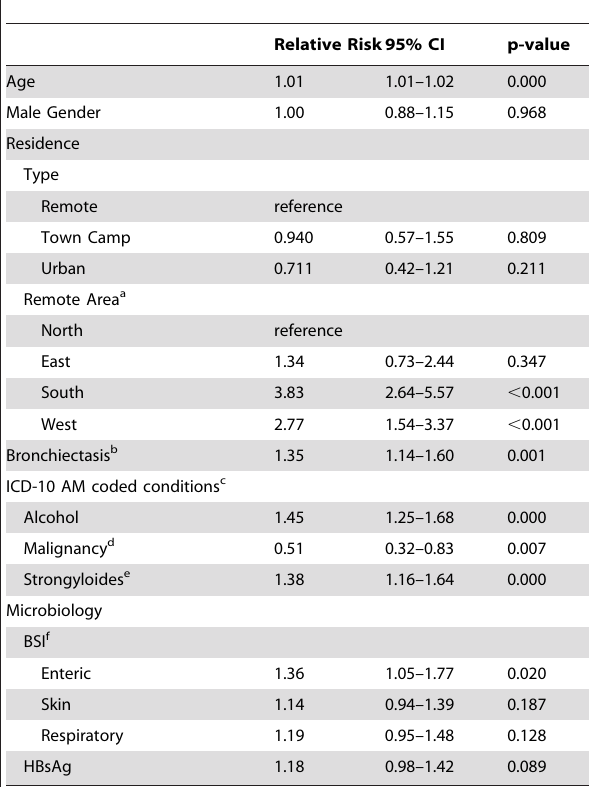
Table 2. Adjusted Poisson modeling of predictors of HTLV-1